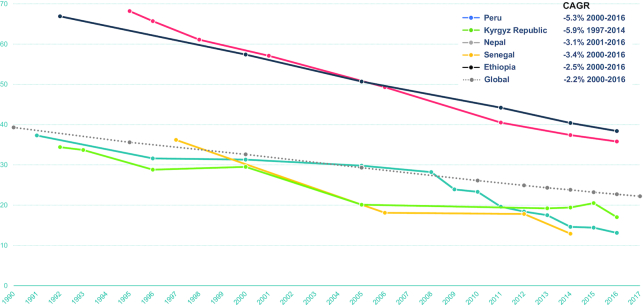
Trends in child stunting prevalence in exemplar countries (1990–2016). CAGR, compound annual growth rate.